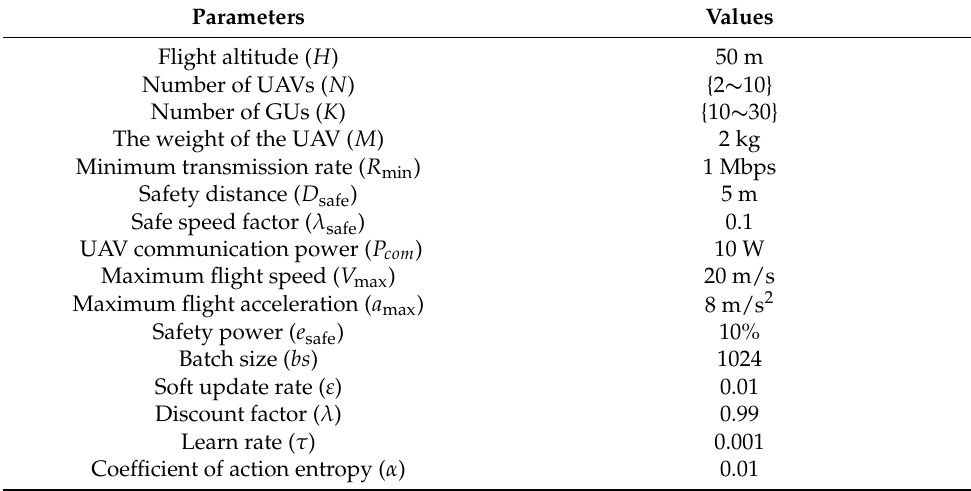
Table 2. Simulation